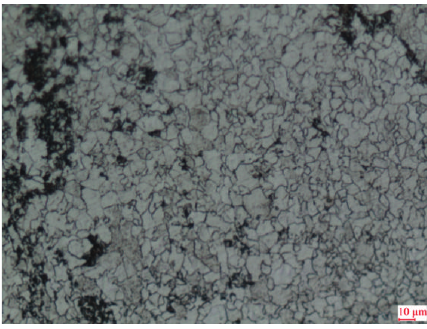
Figure 1: Microstructure of carbon steel API 5L X-70 under